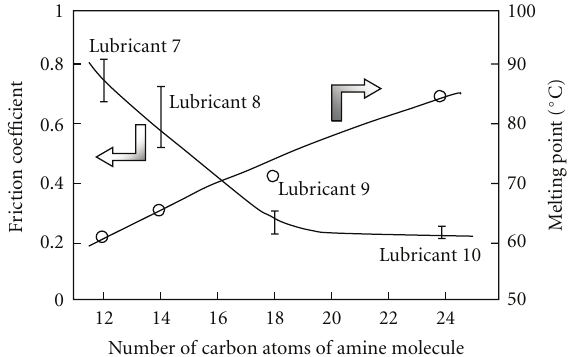
Figure 10: Friction coe ffi cients of the salt type lubricants after 20,000 CSS operations.